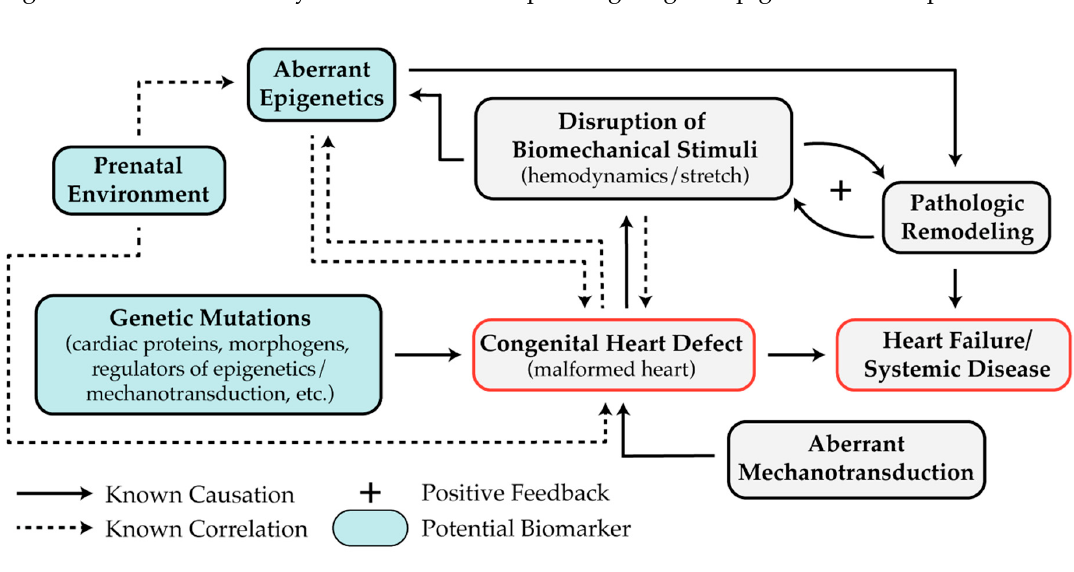
Figure 4. The disruption of highly synchronized regulators of gene expression leads to congenital heart disease. Crosstalk between genetics, mechanics, epigenetics, CHD, and the environment.